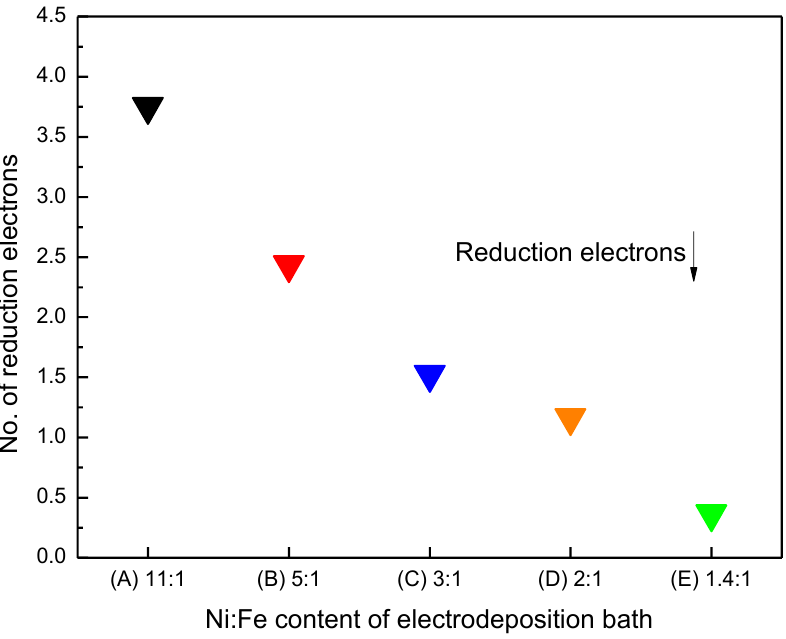
Figure 10. Number of electrons transferred during reduction {NiOOH → Ni(OH) 2 } obtained by integration of the area in the CV curve.